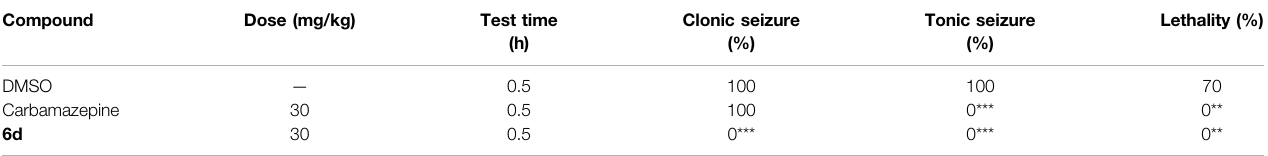
TABLE 3 | Effect of compound 6d on 3-mercaptopropionic acid-induced seizures in mice. Compound